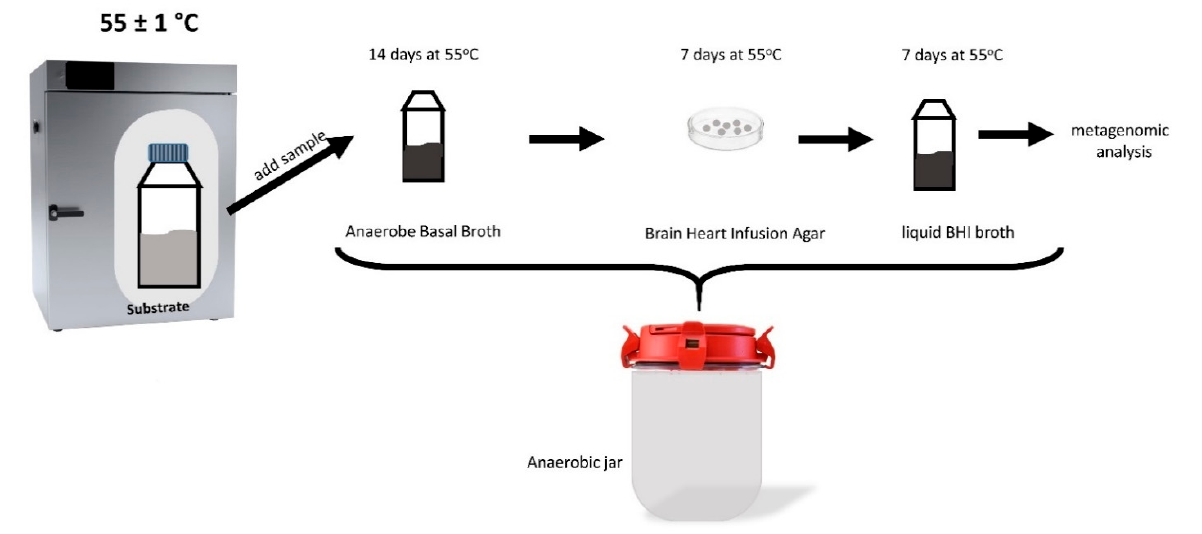
Figure 3. Laboratory stage of microbial isolation.